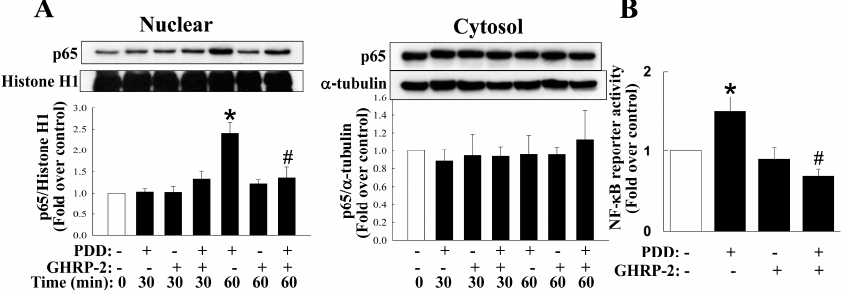
Figure 8. Inhibition of PKC-induced NF- κ B nuclear translocation and activation by GHRP-2. ( A ) Plated KGN cells were pretreated with GHRP-2 for 10 min before the inclusion of PDD (100 nM) for additional 30 or 60 min. The amount of nuclear and cytosolic NF- κ B p65 subunit present in these fractions was monitored by Western blotting assay. ( B ) To monitor NF- κ B reporter activity, plated KGN cells were transfected with a plasmid bearing NF- κ B responsive elements fused with a luciferase reporter gene and co-transfected with the pCMV- β -Gal as a control plasmid. Transfected cells were untreated, treated with either PDD (1 µM) or GHRP-2(1 µM) alone or treated with a combination of PDD and GHRP-2 for 12 h. The NF- κ B reporter activity was determined by luciferase assay and normalized against the β -galactosidase activity from pCMV- β -Gal of the same samples. The results represent the means ± SEM (( A ): n = 4; ( B ): n = 3) separate experiments. * p < 0.05 compared with the control; # p < 0.05 compared with the PDD treatment.